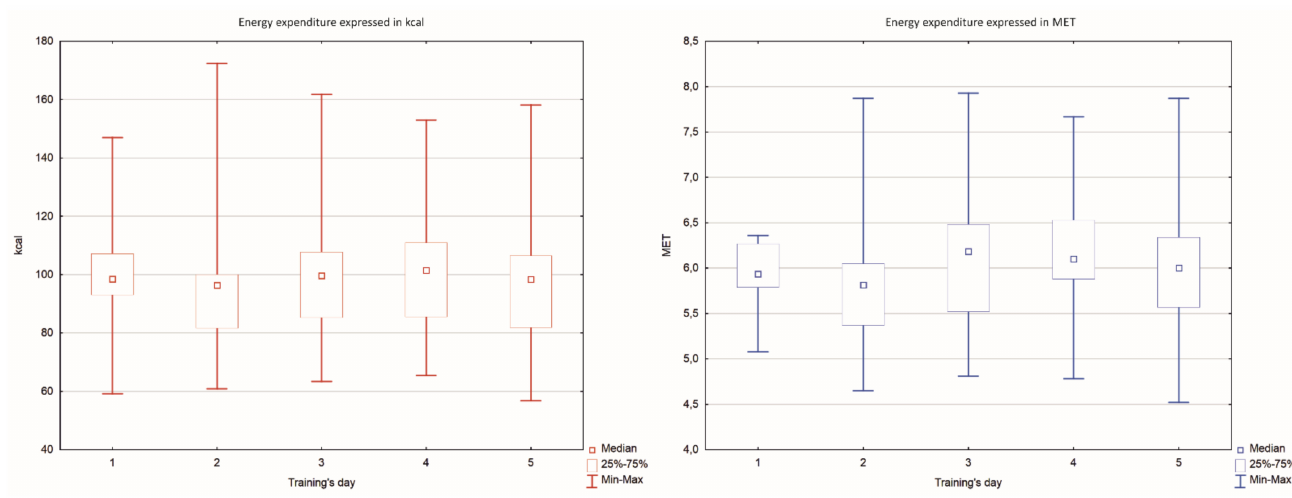
Figure 3. Energy expenditure results. No significant difference between training’s days was found ( p > 0.05). MET: metabolic equivalent; kcal: kilocalories.